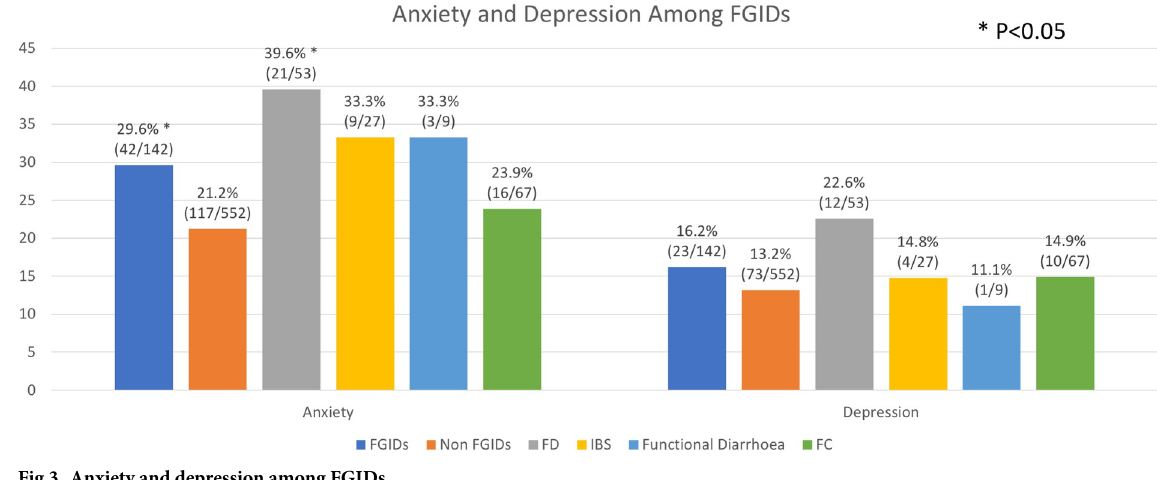
Fig 3. Anxiety and depression among